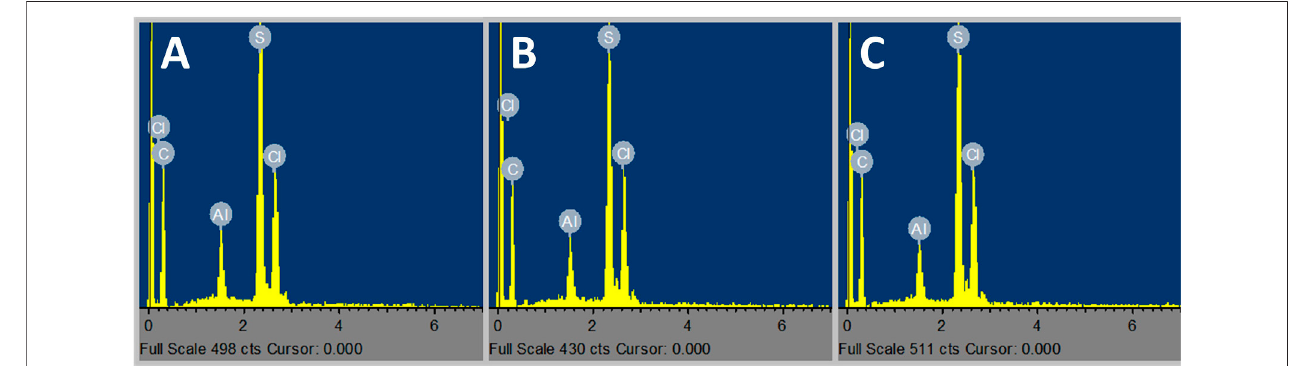
FIGURE 7 | EDS spectra of (A) chlorobenzene, (B) toluene and (C) chloroform prepared HTB-co-P3HT fi